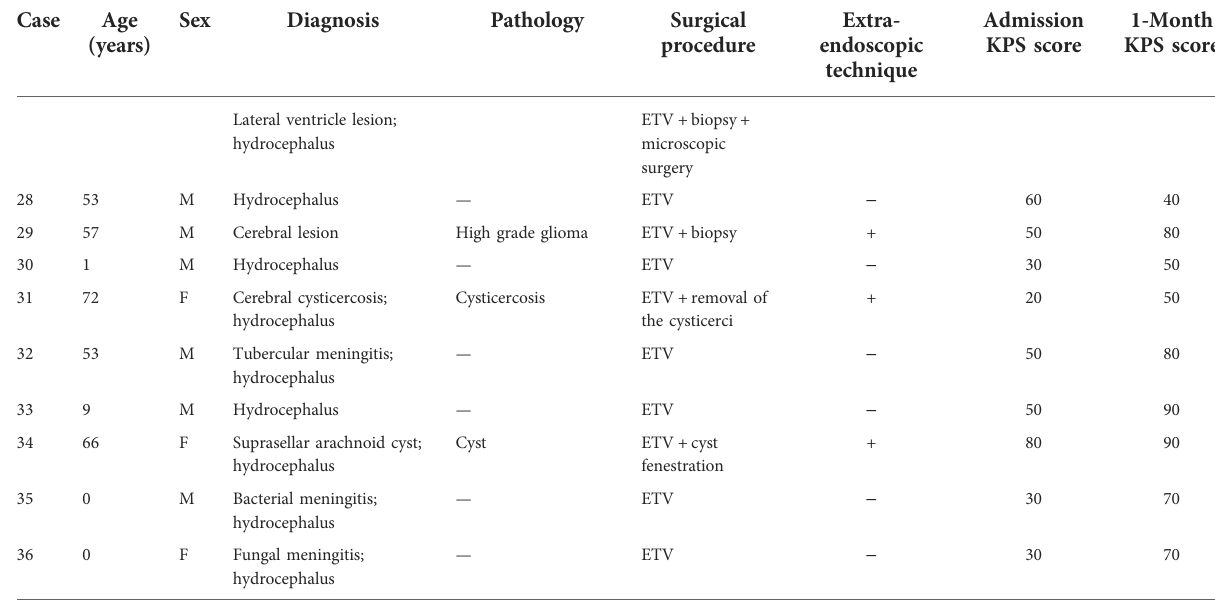
Video 1 . Postoperatively, the patient ’ s symptoms improved, although Acinetobacter baumannii was cultured from the samples of the CSF. Family members gave up treatment citing fi nancial reasons and the patient was discharged.